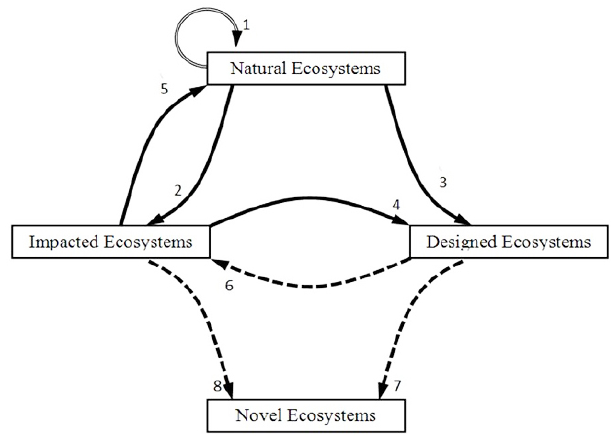
Fig. 2 . The role of human agency in the creation and maintenance of altered ecosystems. Arrows: (1) natural ecosystem processes, (2) unintentional alteration or intentional degradation, (3) altering ecosystem services for clear human gains, (4) environmental remediation, (5) ecosystem restoration, (6) lack of maintenance, and (7 and 8) novel